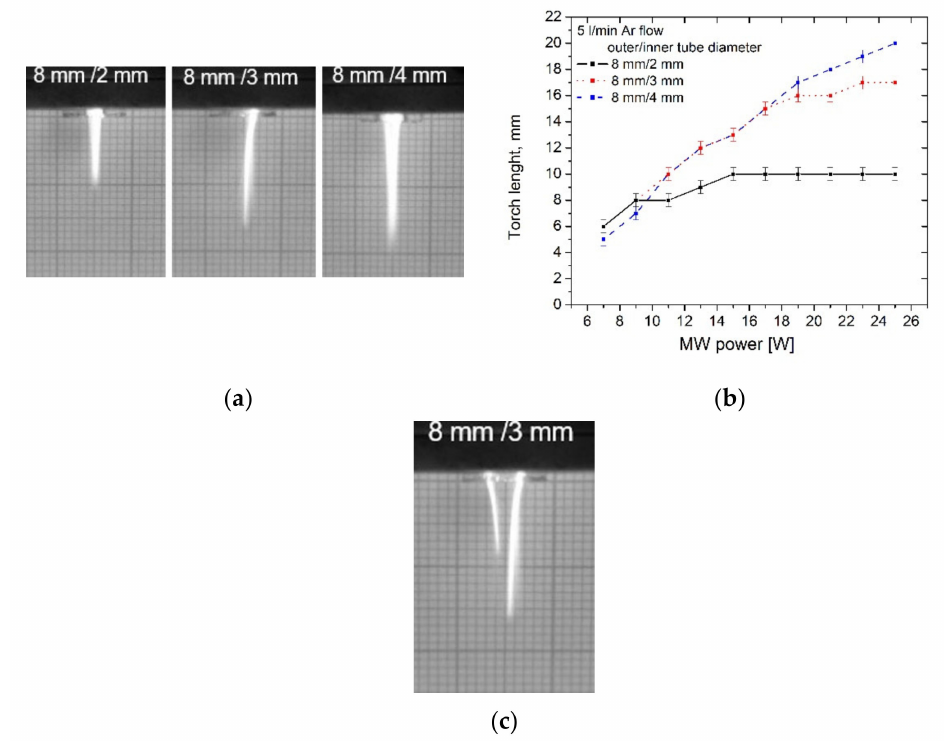
Figure 6. ( a ) Fast camera images of the plasma torch in the three tubes. ( b ) Experimental results for the plasma torch length in the three tubes. ( c ) Appearance of a second filament at higher wave power for 8 mm/3 mm